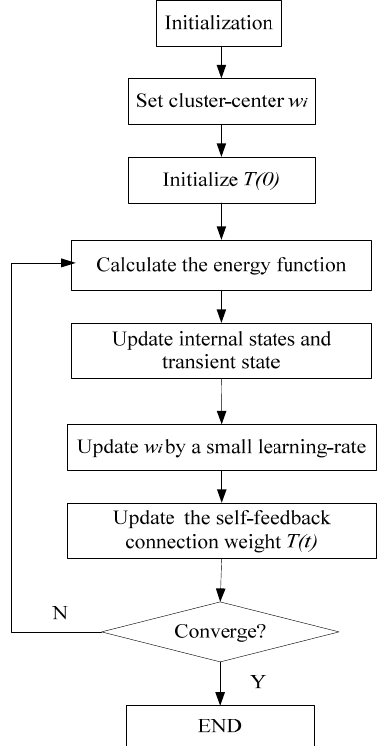
Figure 9. Flow chart of annealed chaotic competitive neural network (ACCLN).